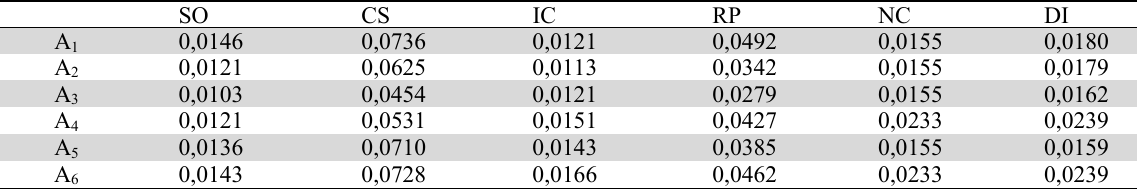
Weighted normalized decision matrix SO